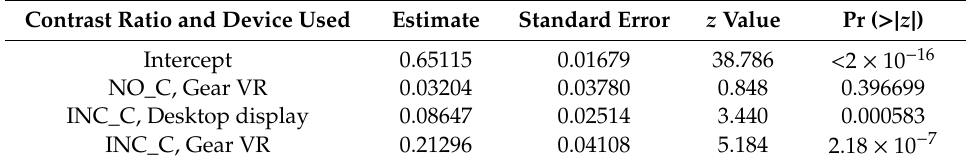
Table A14. The results of the logistic regression analysis are presented in Table 25. Table 25. Logistic regression analysis results of the additive model with variable contrast ratio and device used, allowing